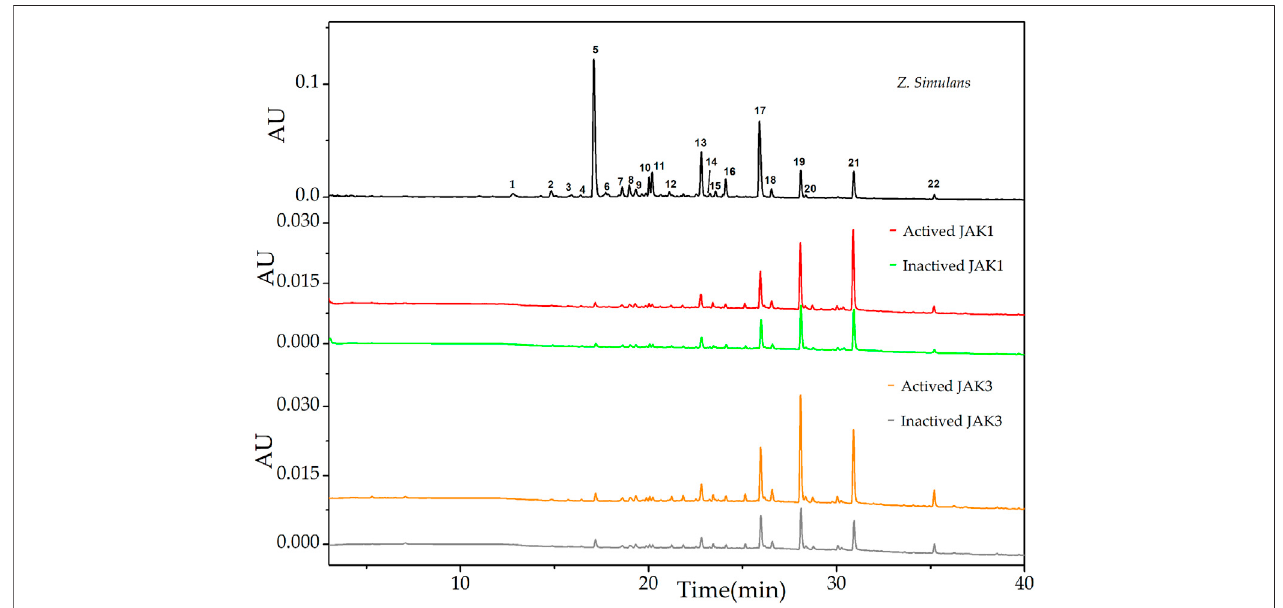
FIGURE1| UF-LCchromatogramsofthepotentialligandsfromtotalalkaloidsof Z.simulans forJAK1andJAK3.InactiveJAK1andJAK3wereproducedbyapre- boiledwaterbathandconductedultra fi ltrationinparallelwithactiveJAKs.Differentcolors,redandgreen,wereusedtoindicateactiveandinactiveJAK1treatment,while orange and gray for active and inactive JAK3,